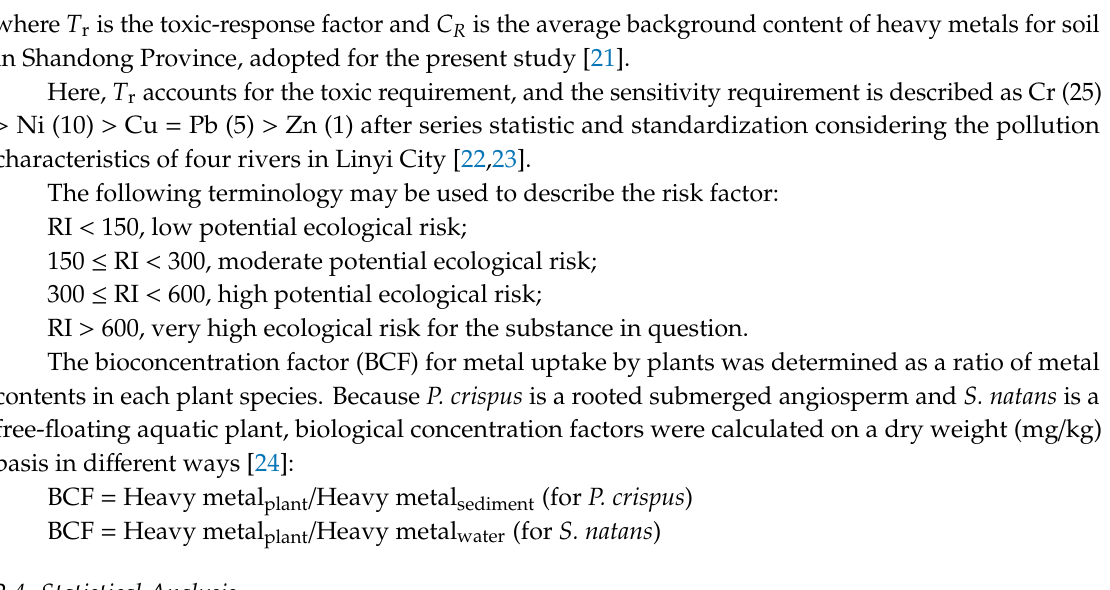
Table 2. Heavy metal levels of the water samples in April and September, 2017. ( µ g / L).